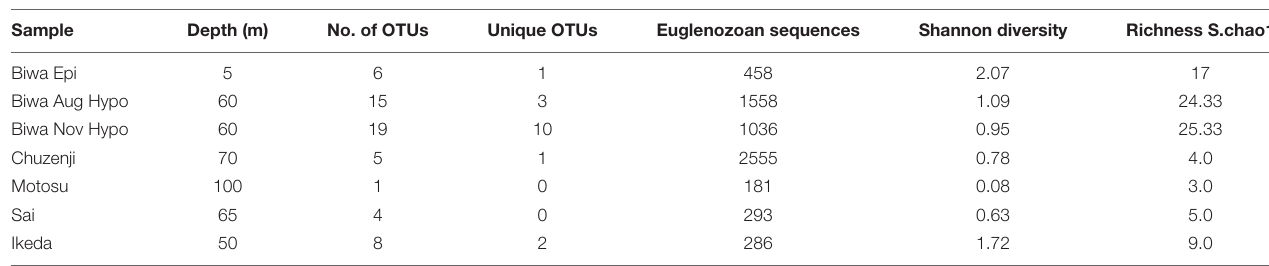
TABLE 2 | Details of individual libraries with kinetoplastid-specific